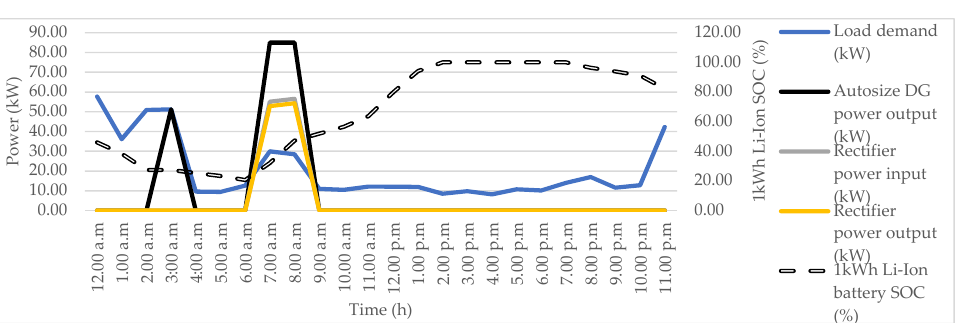
Inverter operation for the month of June.